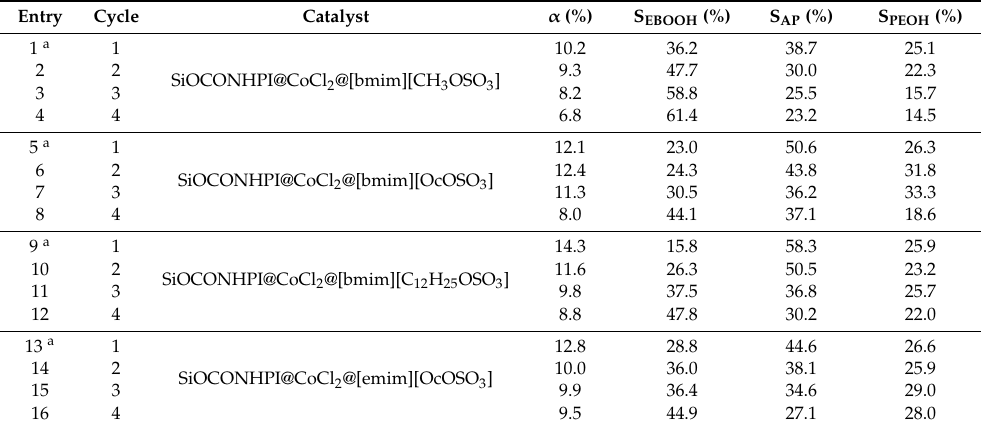
Table 4. Influence of ionic liquid structure on possibility to recycle SiOCONHPI@CoCl 2